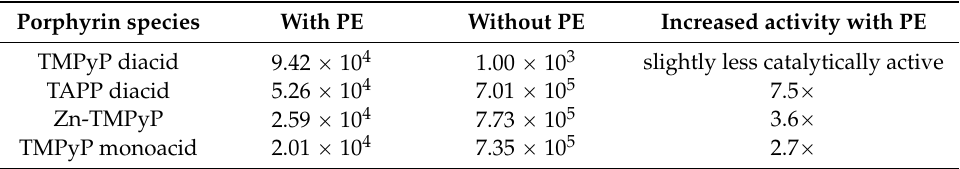
Table 6. TON/TOF for the long-term studies of porphyrin-polyelectrolyte assemblies. TON TOF/min ´ 1 Porphyrin species With PE Without PE With PE Without